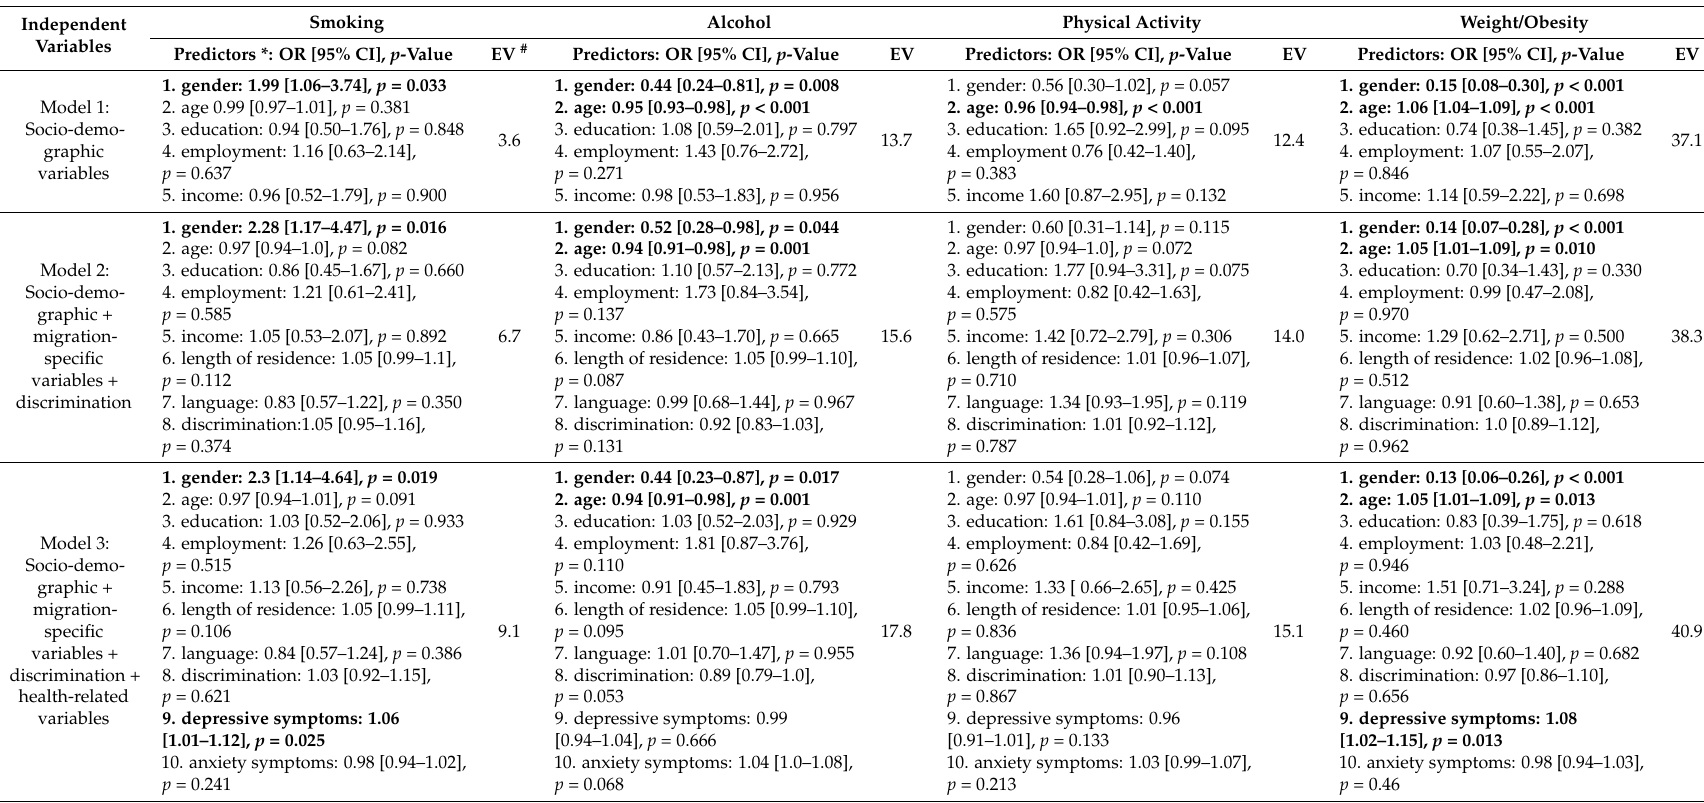
Table 4. Odds Ratios (OR) with 95% confidence intervals (CI) for smoking, alcohol consumption, physical activity, and overweight/obesity in immigrants of Polish